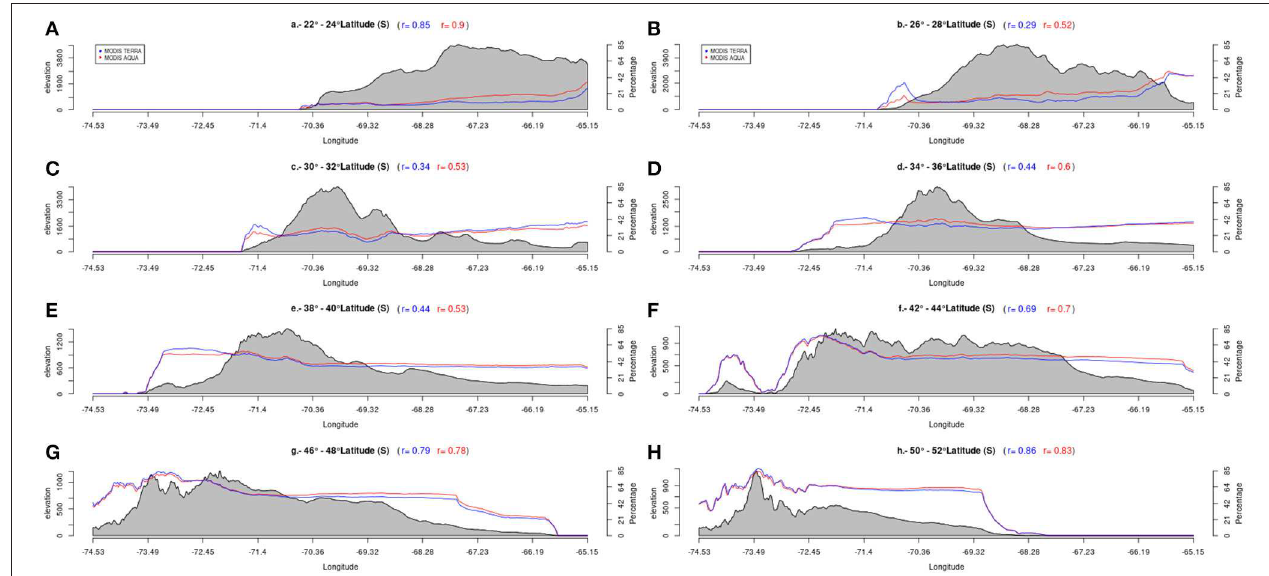
FIGURE 6 | Cross-barrier plots of the meridionally averaged altitude of the Andes (shaded) and cloud fractions (lines) between (A) 22 – 24 ◦ S, (B) 26–28 ◦ S, (C) 30 – 32 ◦ S, (D) 34–36 ◦ S, (E) 38–40 ◦ S, (F) 42–44 ◦ S, (G) 46–48 ◦ S, and (H) 50–52 ◦ S. Cloud fraction is calculated using the MODIS product from onboard of polar-orbiting Terra (blue line) and Aqua (red line) satellites. Terra satellite overpass South America around 1500 UTC (1200 LT, noon time), while Aqua overpass around 1800 UTC (1600 LT afternoon time). The correlation coefficients between the topographic profile and the cloud fraction are also shown in blue and red for those derived Terra and Aqua times,